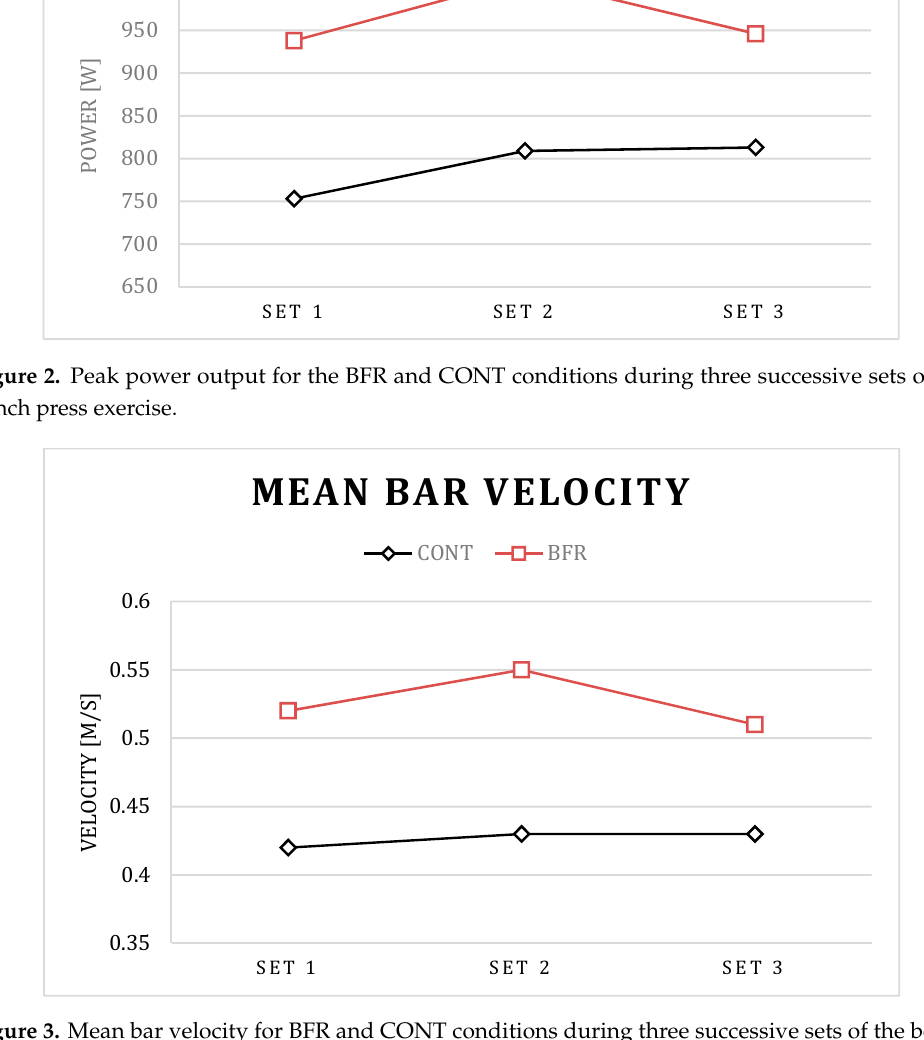
Figure 3. Mean bar velocity for BFR and CONT conditions during three successive sets of the bench press exercise.